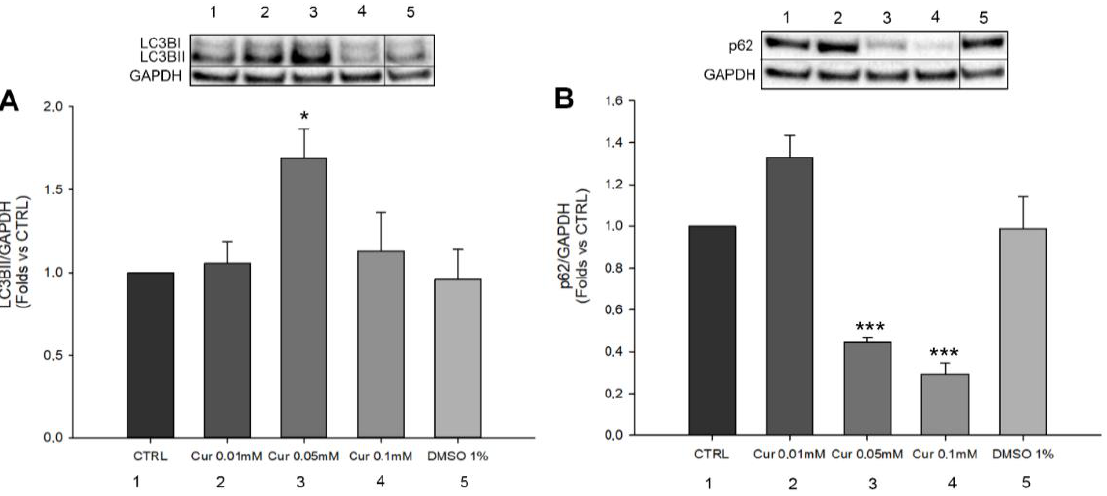
Figure 7. Autophagic markers quantification. ( A , B ) Quantification of LC3BII and p62 protein levels on ARPE-19 cells treated with Cur (0.01 mM; 0.05 mM and 0.1 mM) and DMSO 1% for 24 h. ( B ) Western Blot analysis of p62 expression on ARPE-19 cells treated with Cur and DMSO for 24 h. Statistical analysis was performed using one-way ANOVA followed by Dunnet’s test. * p < 0.05; *** p < 0.001 versus CTRL (n = 4). The expression analysis of LC3BII and p62 in all the vehicles groups are reported in Figure S6. Original Western Blot bands of LC3BII and p62 are showed in Figure S9 and Figure S10, respectively.